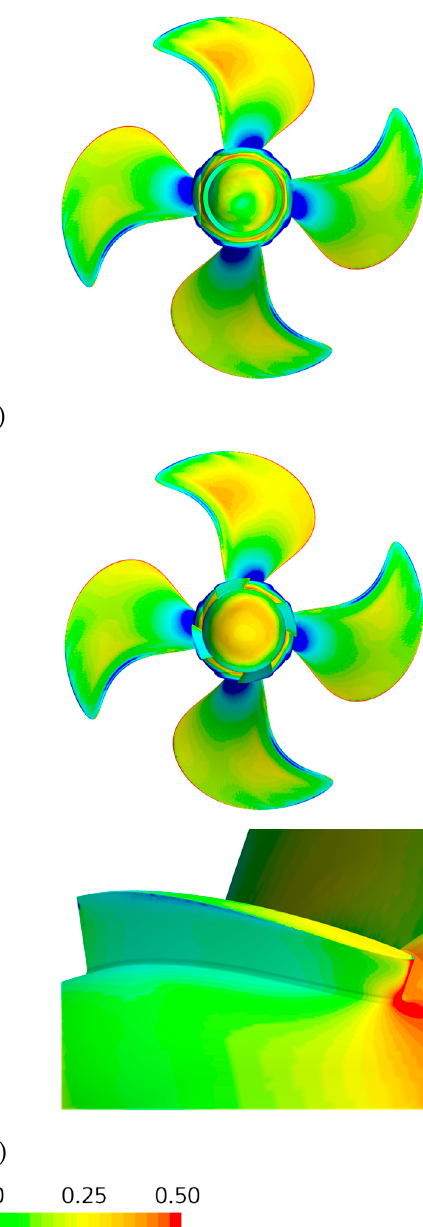
Figure 9. Pressure coefficient C p on or around ( a ) the original propeller/rudder and ( b ) the new propeller/rudder with optimized PBCFs with the water flow of 2.25 m/s from the left to the right and rotational speed of 608 rpm. ( a ) Original propeller/rudder system: side view ( left ) and downstream view from the rudder ( right ). ( b ) Propeller/rudder system with new optimized PBCFs: side view ( top left ), downstream view from the rudder ( top right ), pressure side of a fin with the flow from left to right ( bottom left ), and suction side of a fin with the flow from right to left ( bottom right ).